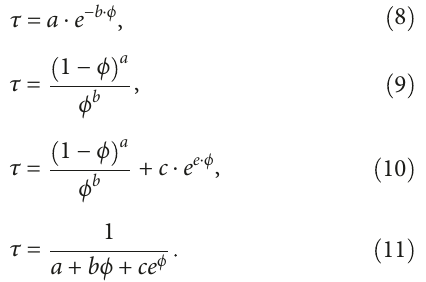
Figure 12: E ff ect of proppant distribution on conductivity at di ff erent embedment ratios.